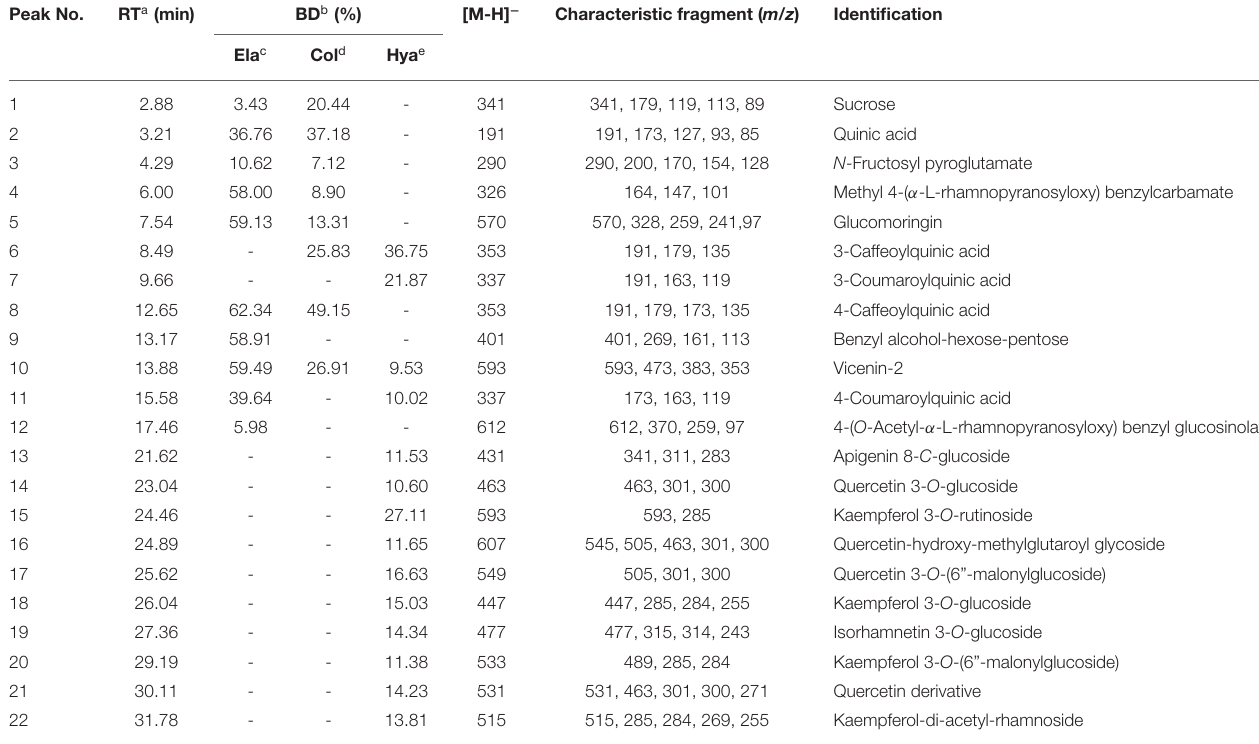
TABLE 1 | The binding degree (BD) and the affinity ultrafiltration coupled with high-performance liquid chromatography-mass spectrometry (AUF-LC/MS) data of the bioactive compounds bound to elastase, collagenase, and hyaluronidase enzymes from Moringa oleifera leaf extracts. Peak